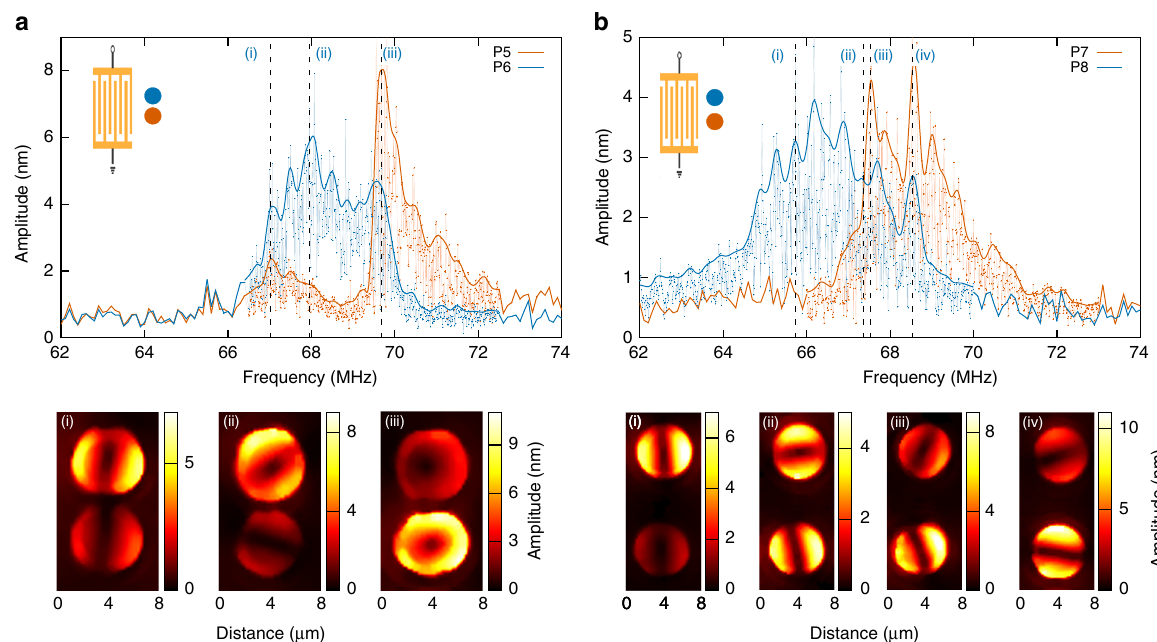
Fig. 4 Transverse excitation. a Experimental frequency responses of the 1.5 µ m-spaced pillars in the transverse-excitation con fi guration. Bottom: corresponding out-of-plane displacement fi eld maps for typical excitation frequencies: 67.02 MHz (i), 67.95 MHz (ii) and 69.68 MHz (iii). The scan area is 8 µ m × 14 µ m, with a step size of 200 nm. b Experimental frequency responses of the 6 µ m-spaced pillars in the transverse-excitation con fi guration. Bottom: corresponding out-of-plane displacement fi eld maps for typical excitation frequencies: 65.73 MHz (i), 67.37 MHz (ii), 67.53 MHz (iii) and 68.53 MHz (iv). The scan area is 8 µ m × 19 µ m, with a step size of 200